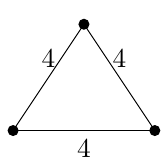
Figure 10 . The Coxeter diagram for the triangulation of H 2 with Schl(cid:127)a(cid:13)i symbol f 3 ; 8 g